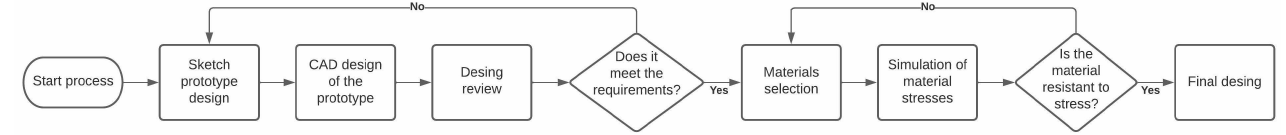
Figure 2. Methodology for the design and construction of the